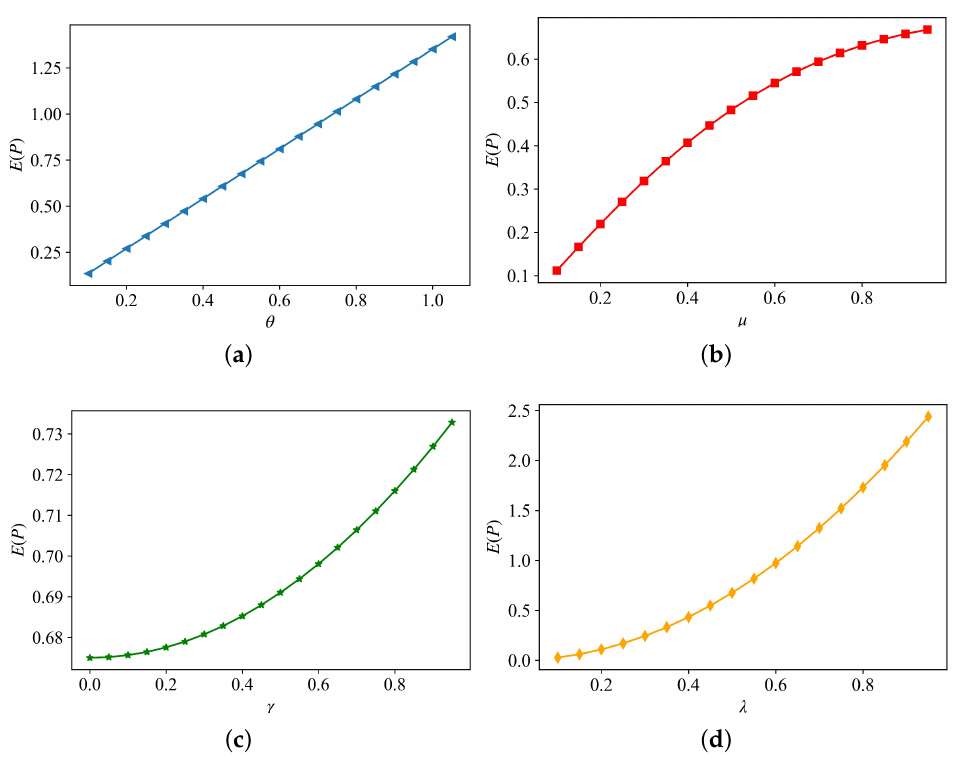
Figure 7. The variations in the mean output power with different ( a ) electromechanical coupling coefficient θ , ( b ) time constant ratio µ , ( c ) noise intensities γ and ( d ) piezoelectric coupling term λ